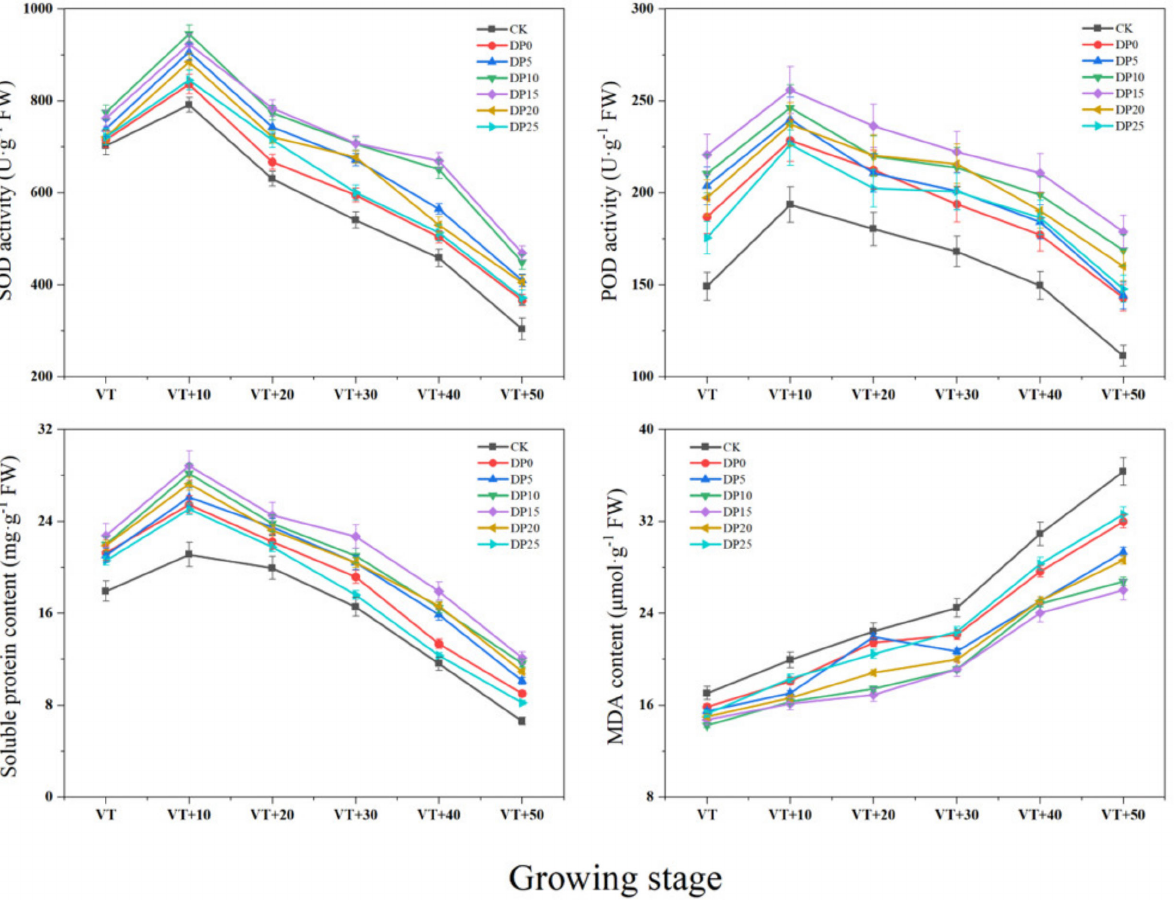
Figure 4. Effects of different basal application depths of controlled-release urea on activity of SOD and POD, content of MDA and soluble protein in panicle leaf after tasseling. CK: no fertilizer; DP0: surface application; DP5: fertilization depth 5 cm; DP10: fertilization depth 10 cm; DP15: fertilization depth 15 cm; DP20: fertilization depth 20 cm; DP25: fertilization depth 25 cm. Thin vertical bars are standard errors ( n =